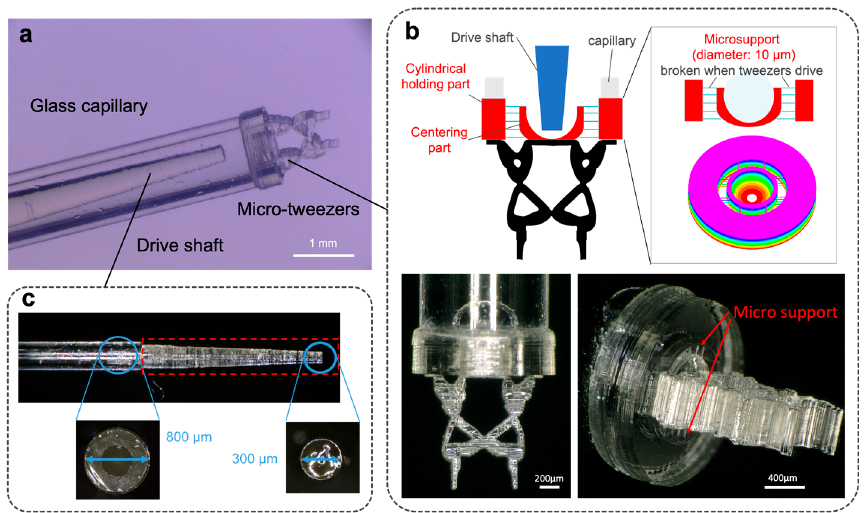
Figure 5. Topology-optimized micro-tweezers fabricated using microstereolithography: ( a ) Overall view of the fabricated micro-tweezers on a glass capillary with a drive shaft; ( b ) Details of the base parts to support the tweezers on the glass capillary; ( c ) Additively fabricated drive shaft used for pushing the tweezers.